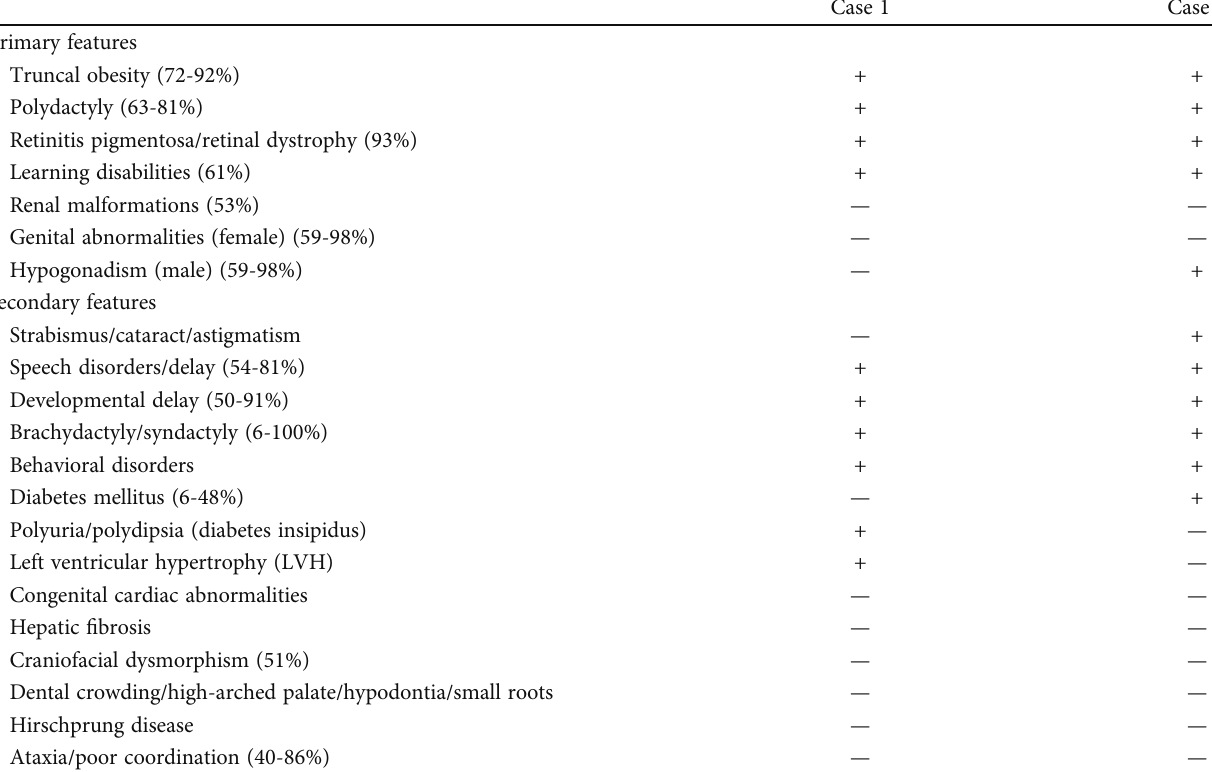
Table 1: Diagnostic criteria for Bardet – Biedl syndrome